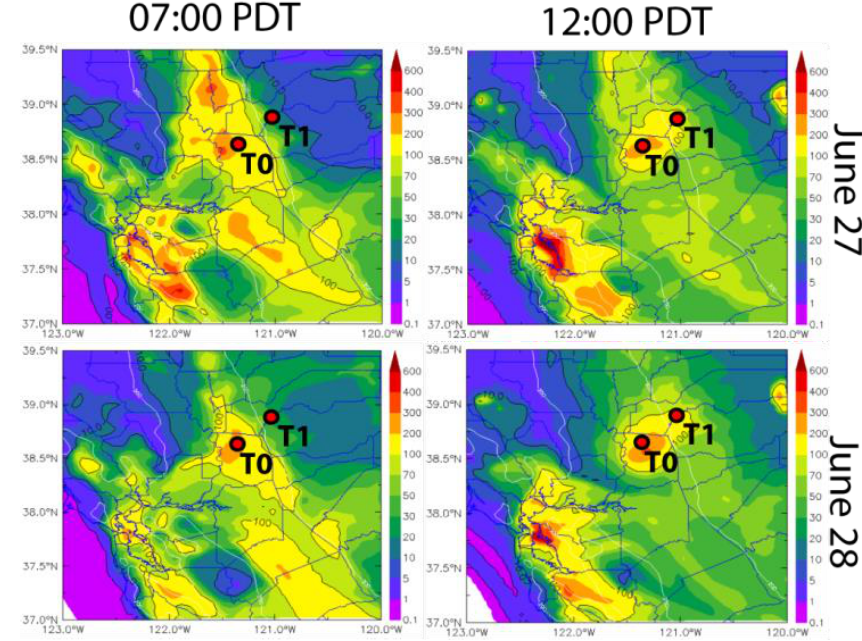
Fig. 2. Ensemble tracer maps for the Bay Area and Sacramento urban areas for 27–28 June 2010. Figure 2. Simulated distribution of CO tracer (ppb) from all anthropogenic sources in the 4 vicinity of the Bay Area and Sacramento at two times on June 27 and 28, 2010.. 5